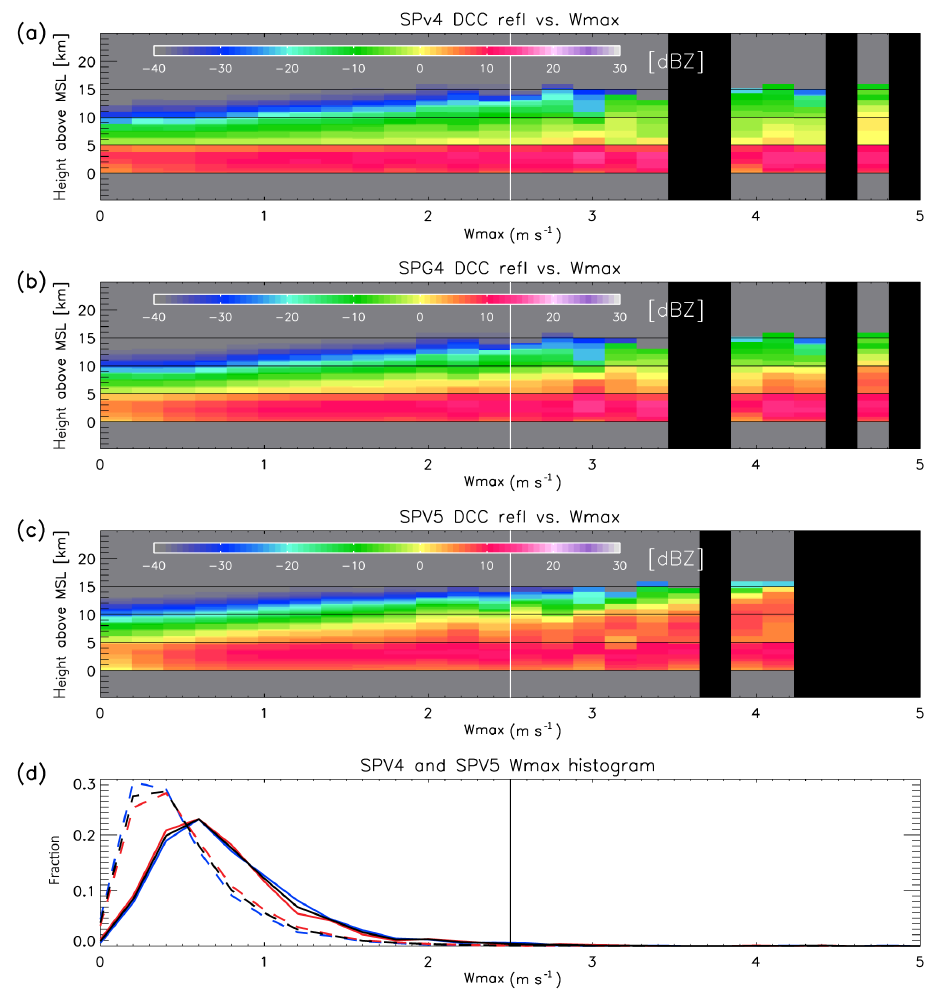
Figure 8. (a) Mean vertical profiles of simulated DCC radar reflectivity in SPV4 sorted by maximum updraft velocity. The vertical lines at 2.5ms − 1 represent the maximum cut off W max value for statistical calculations. Vertical black stripes are updraft values with no DCC occurrences. (b) Same as (a) , but for SPG4 data. (c) Same as (a) , but for SPV5 data. (d) PDFs of maximum DCC updraft velocity for (solid) SPV4 and (dashed) SPV5. The black line represents data from both 02:00 and 14:00LST, the blue line from 02:00LST (night-only), and the red line from 14:00LST